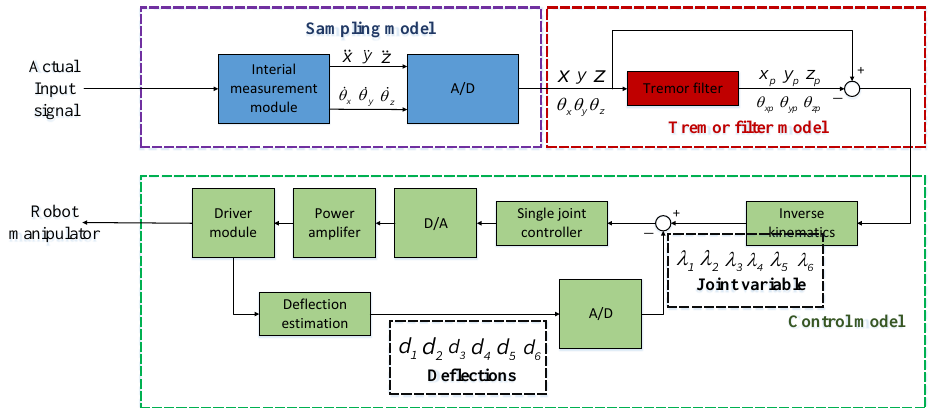
Figure 4. Block diagram of the tremor